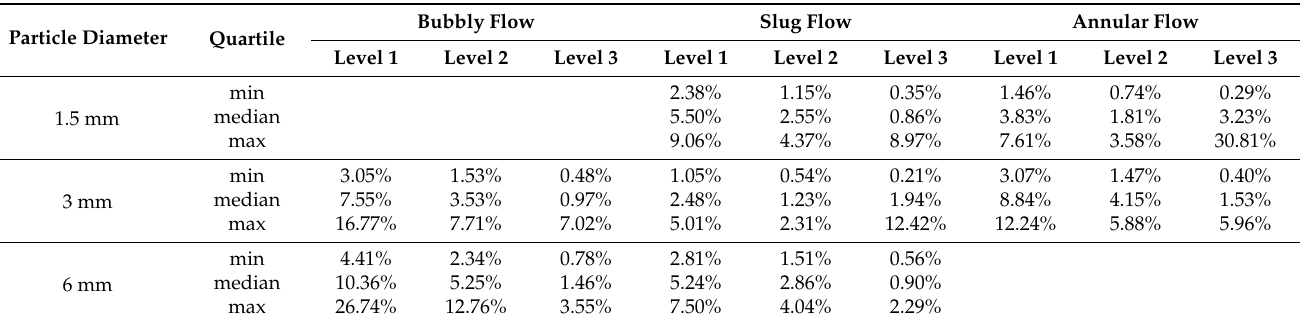
Table 3. Distributions of EMD energy spectrum on levels 1–3.